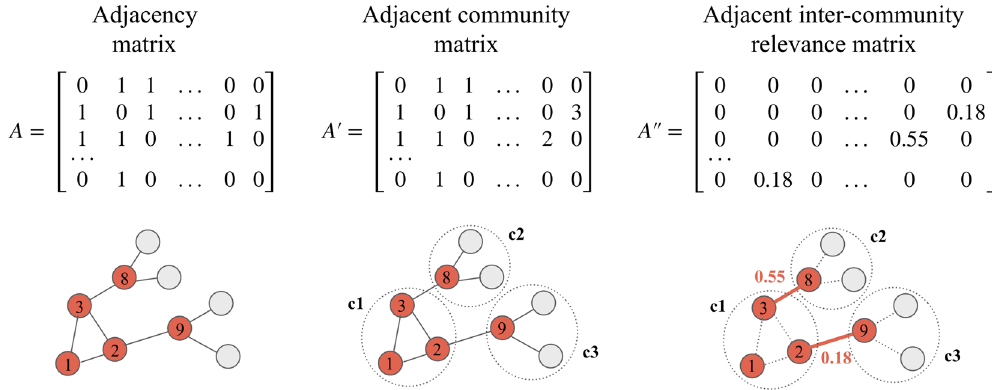
Figure 2. Outline of updating elements in the adjacency matrix to community relevance. The red nodes in the networks are the nodes represented in the matrices. The number of nodes in the network represents the corresponding row indexes in the matrix. Community IDs in the networks are represented as c1, c2, and c3, which correspond to the numbers 1, 2, and 3, respectively, in the adjacent community matrix. The example values of community relevance are represented by the red numbers 0.55 and 0.18 in the right graph, which are equivalent to the values in the adjacent outer community relevance